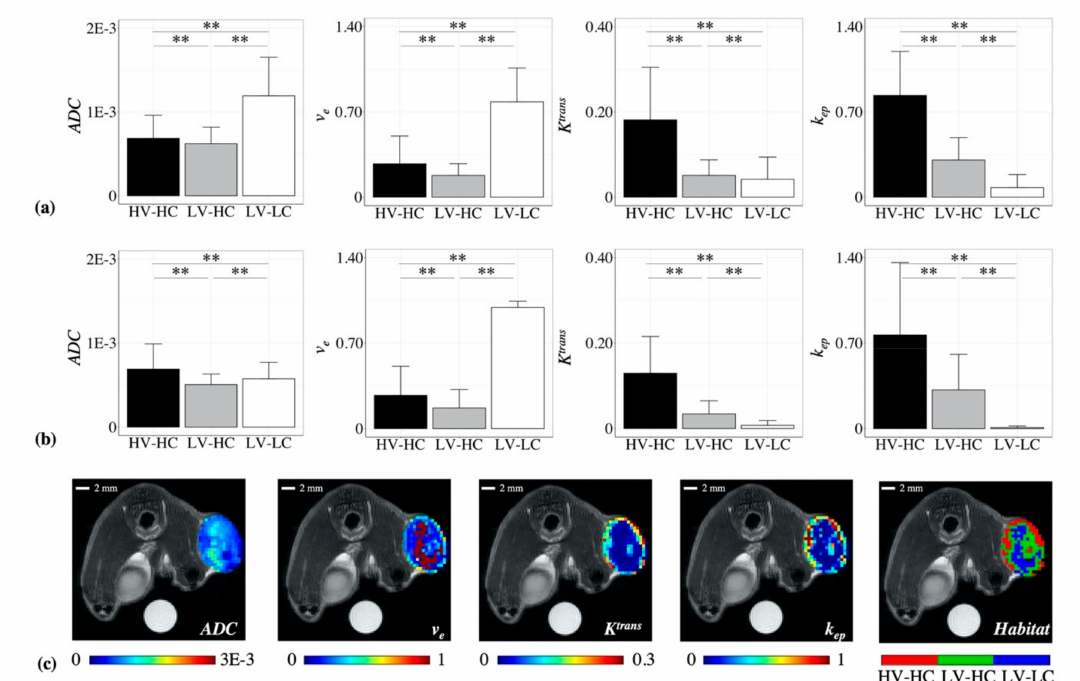
Figure 2. The mean parameter values for each of the identified habitats are shown for the ( a ) BT-474 and ( b ) MDA-MB-231 cohorts. The mean parameter values were used to identify the physiological habitat each cluster represented in terms of high or low “vascularity” or “cellularity”. The three identified habitats were as follows: high-vascularity high-cellularity (HV-HC), low-vascularity high-cellularity (LV-HC), low-vascularity low-cellularity (LV-LC). All three habitats were found in both the BT-474 and MDA-MB-231 cohorts. Error bars show standard deviation and ** indicates a p < 0.01. Panel ( c ) shows representative parameter maps and a corresponding habitat map for an example BT-474 tumor at baseline, where the HV-HC habitat is shown in red, LV-HC in green, and LV-LC in